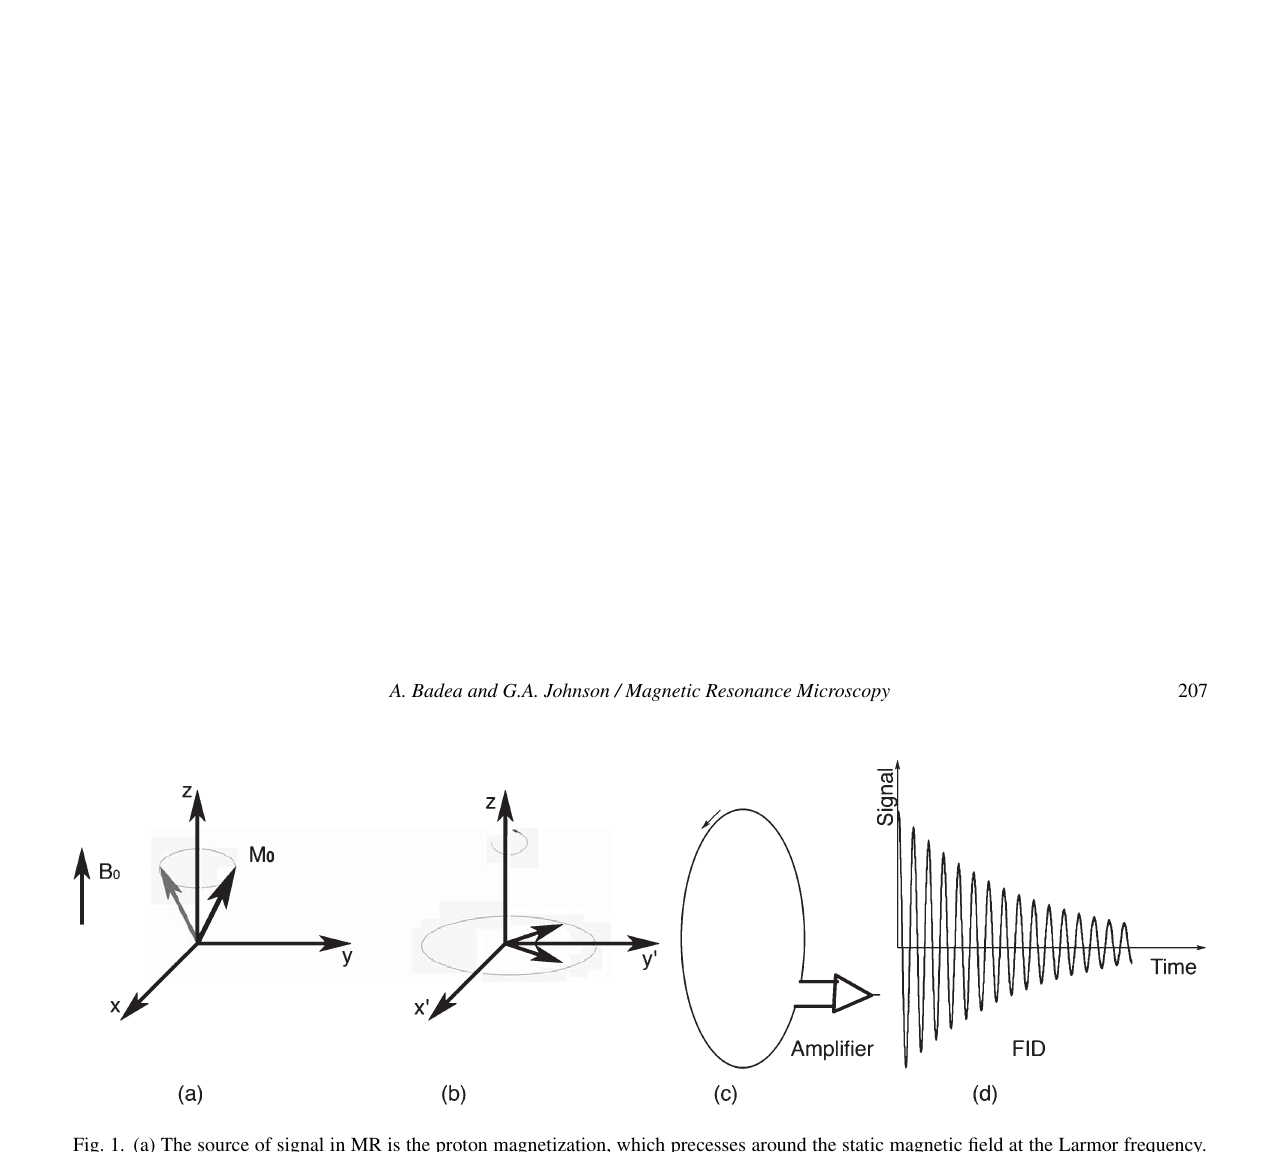
Fig. 1. (a) The source of signal in MR is the proton magnetization, which precesses around the static magnetic field at the Larmor frequency. (b) In a reference frame rotating at this Larmor frequency M 0 appears to be stationary. In the 90-FID pulse sequence, the net magnetization is rotated down into the x’y’ plane with a 90 ◦ RF pulse. (c) A changing magnetic flux induces a current in the receiver coil. (d) The signal recorded in the laboratory frame following the RF pulse constitutes the